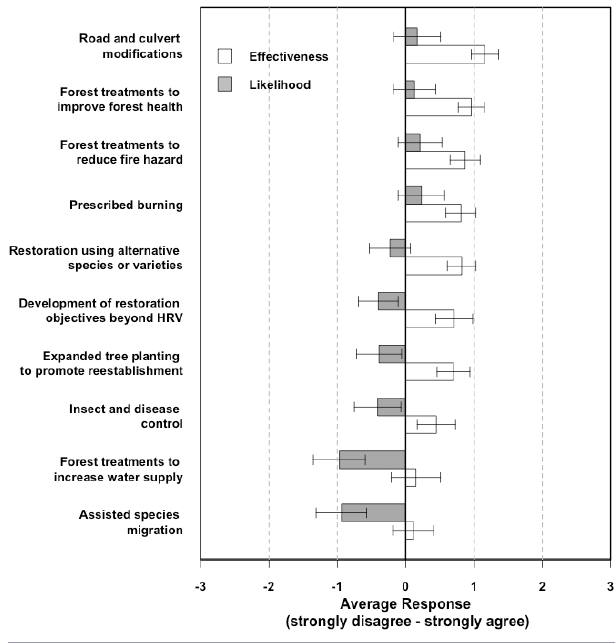
Fig. 3 . Mean response to 10 survey questions asking participants (n = 61) to evaluate the efficacy of different management strategies for adapting to climate change in Idaho and Western Montana. Participants were asked to rate whether they felt they actions listed would be effective (white bars) and the likelihood that their agency would use each action (grey bars) to adapt to the impacts of climate change. Responses were scaled from -3 (very ineffective/unlikely) to +3 (very effective/likely). Management actions that were more likely to be considered effective and likely to be implemented in response to climate change are at the top of the figure. Actions that were perceived to be ineffective and have a low likelihood of implementation are at the bottom of the figure. Error bars indicate ± 2 standard errors around the mean. HRV stands for Historical Range of Variability and refers to the range of potential conditions (e.g., disturbance, climate) that a particular ecotype may have experienced prior to European settlement and heavy anthropogenic manipulation of the